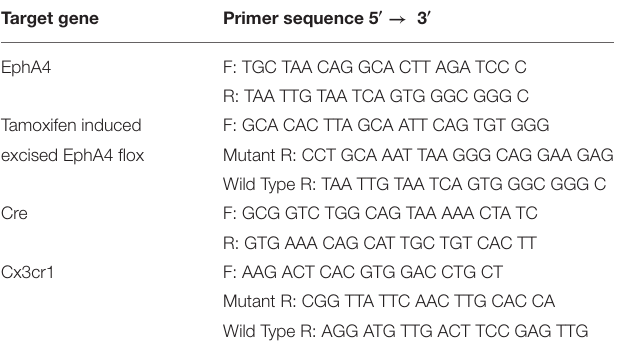
TABLE 1 | Sequence of primers used in